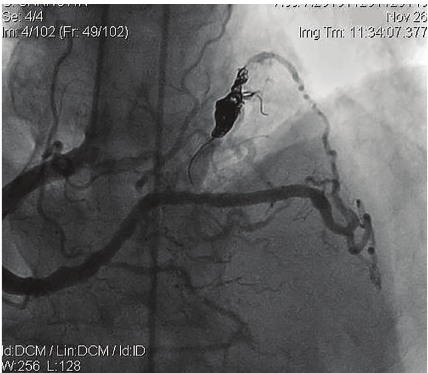
Figure 3: Coronary cine angiogram. Left anterior oblique pro- jection shows single large right coronary artery after the coil